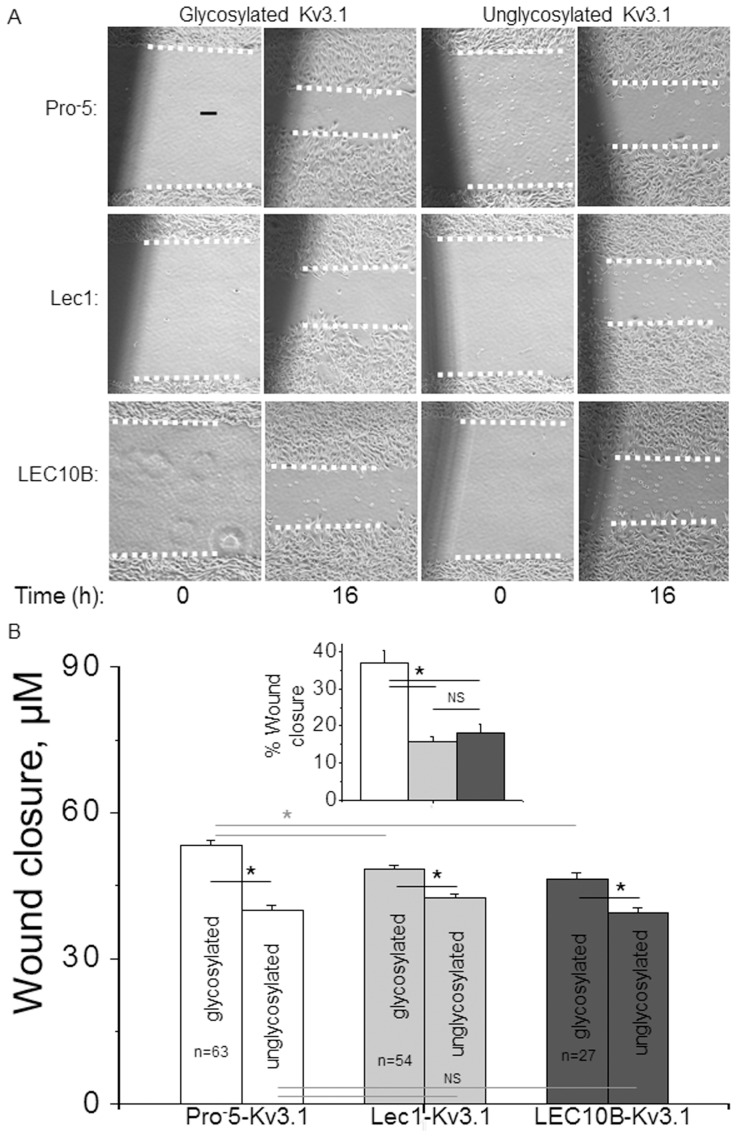
Rate of CHO cell migration is enhanced by Kv3.1.Cell wounds were generated for glycosylated and unglycosylated Kv3.1, and then images were captured at 0 and 16 h time points for Pro-5 (top row), Lec1 (middle row), and LEC10B (bottom row) (A). Rate of cell wound closure was determined for glycosylated and unglycosylated Kv3.1 expressed in the various CHO cell lines (B). Region of wound measured is indicated by the two dotted white lines per image. The percent of wound closure is the increase in wound closure due to the N-glycan attached to Kv3.1 (B, inset). Asterisks indicate significant differences in mean values at a probability of P<0.03.